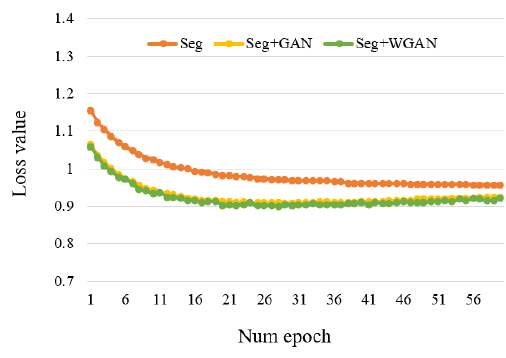
Figure 6. Training loss values of proposed methods on the Vaihingen